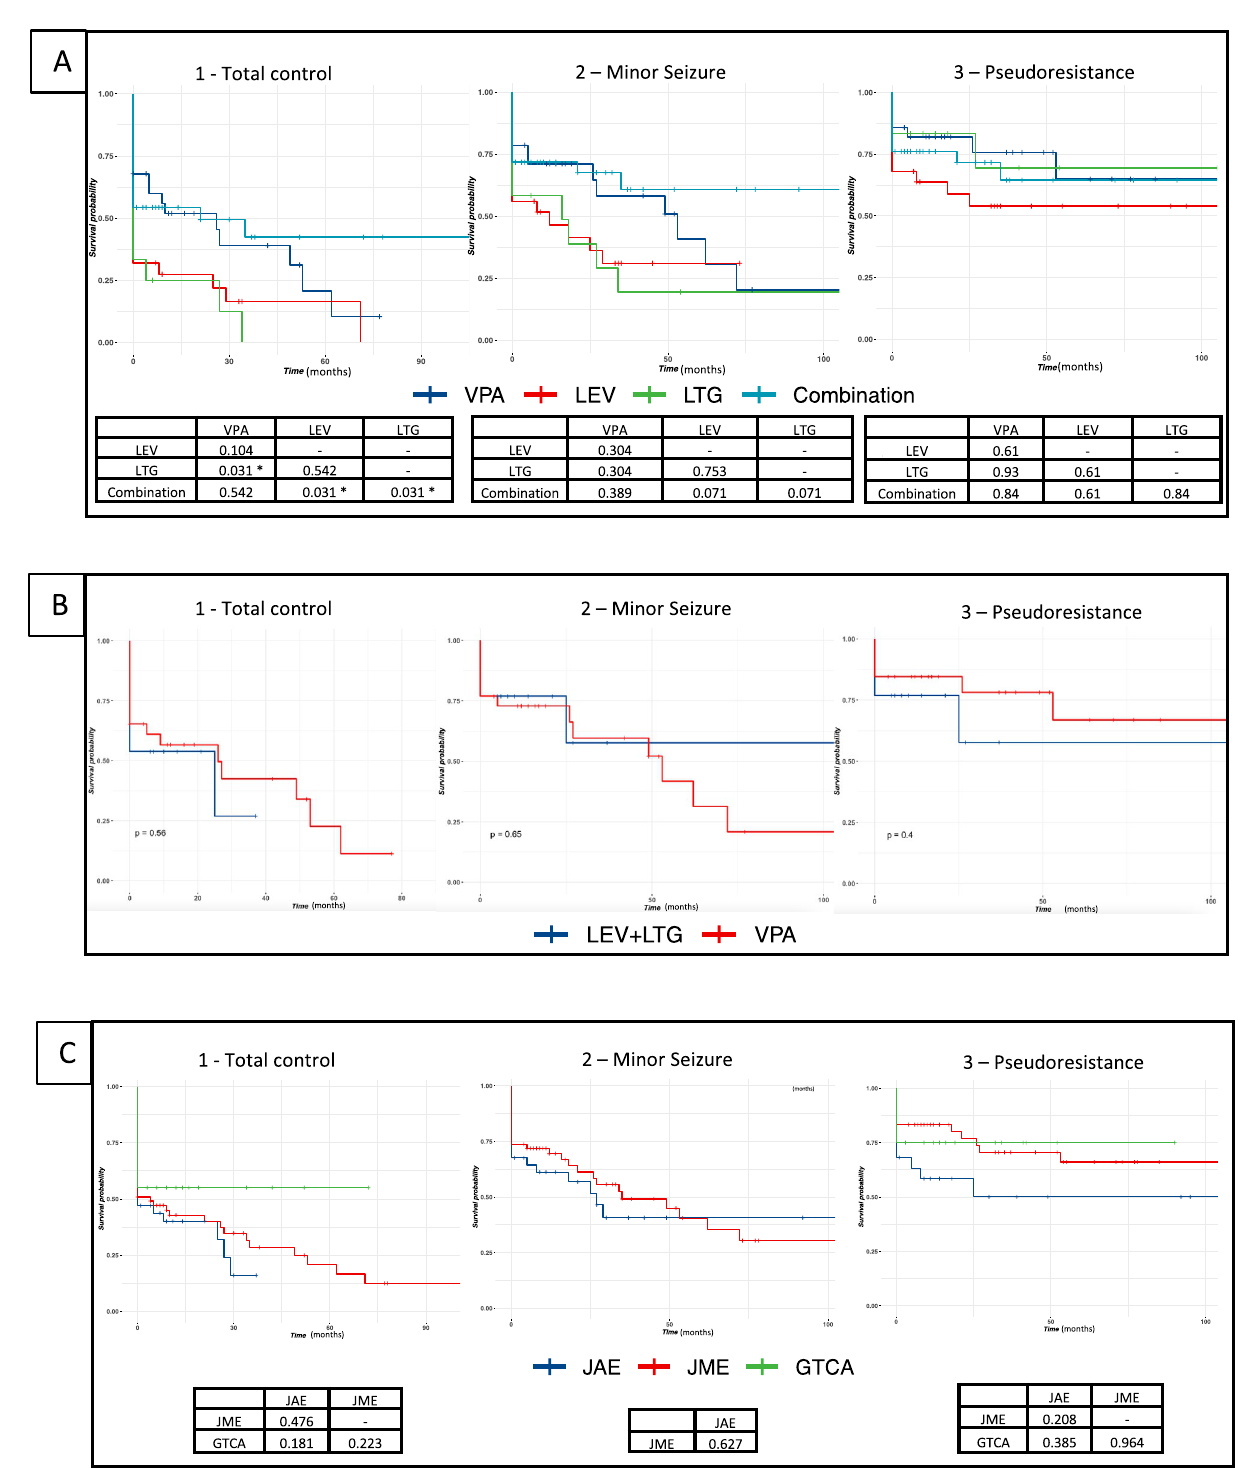
Figure 2. Outcomes for ( A ) Monotherapy and combination therapy; ( B ) VPA and LEV + LTG; ( C ) IGE syndromes. Survival curves for each level of control (total control, minor seizures, and pseudoresistance). The p values for pairwise comparisons are shown in each table